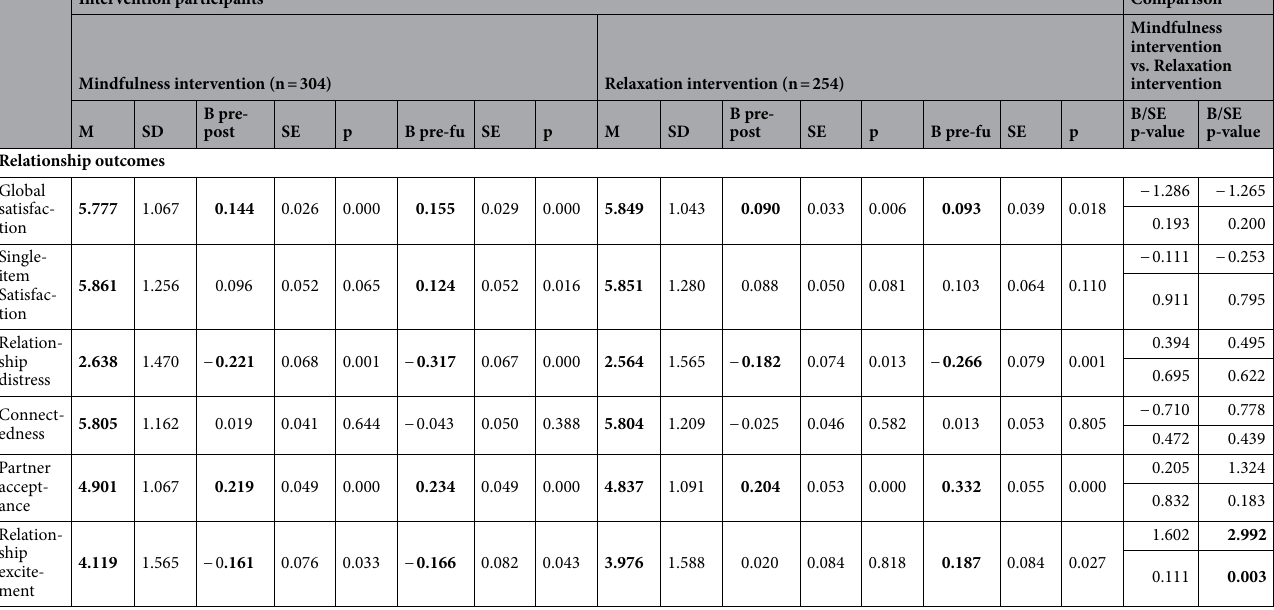
Table 3. Pre-post and pre-follow-up change in relationship outcomes for partners by intervention. Bold print indicates significant effects (p < 0.05).